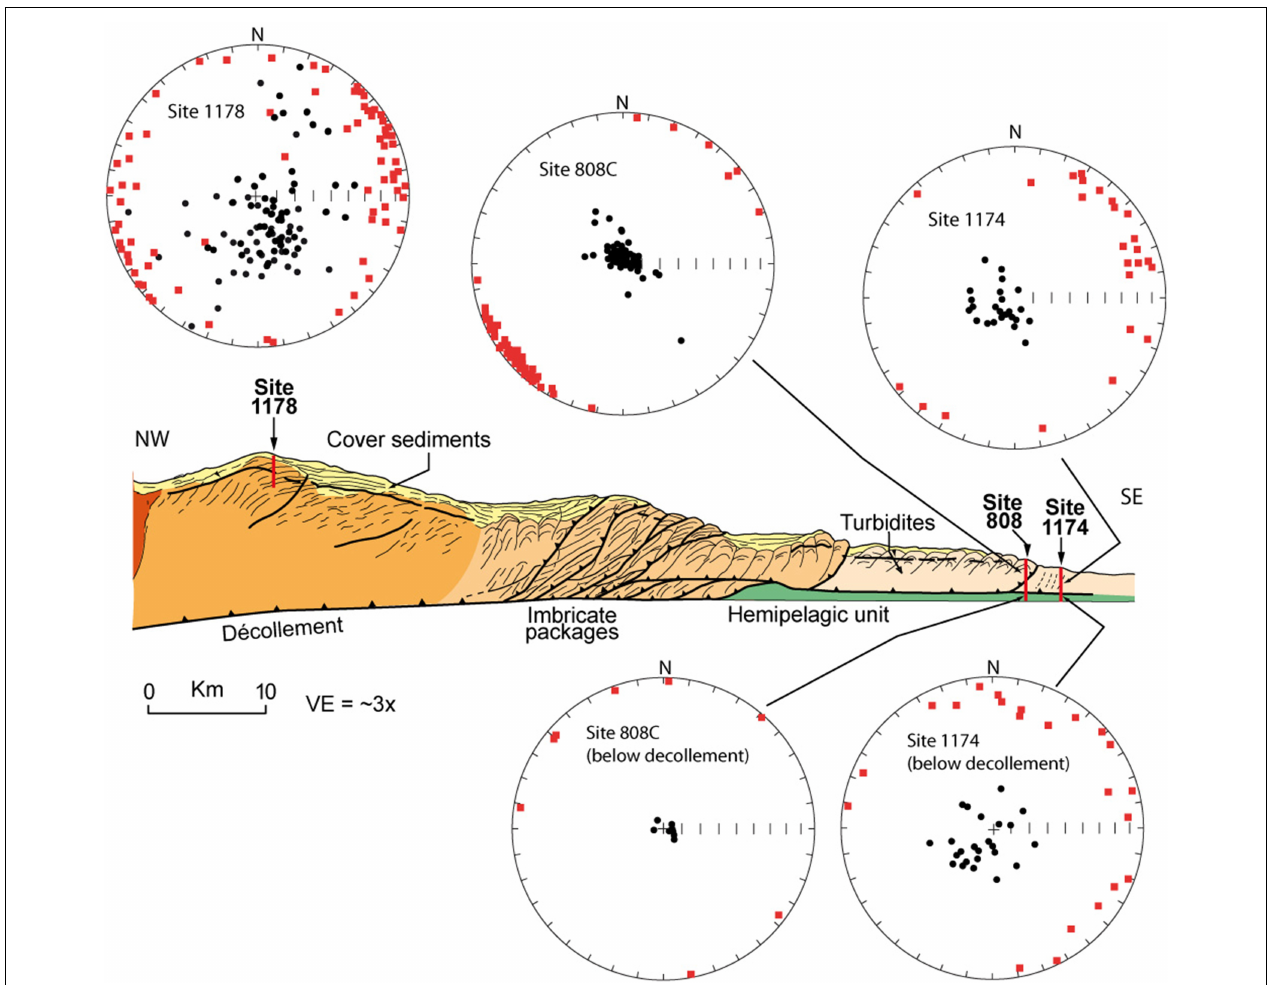
FIGURE 8 | AMS from selected ODP and IODP sites along the Muroto transect (Nankai Trough) (cross section modified from Moore et al., 2001). Lower-hemisphere, equal-area projection of the K max (red squares) and K min (black dots) principal axes of